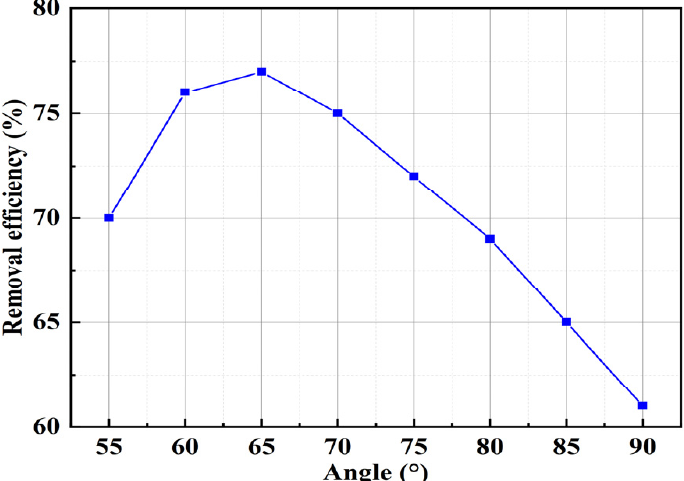
Figure 9. Effect of the angle of inclination of the front intake surface on the efficiency of dust extraction.